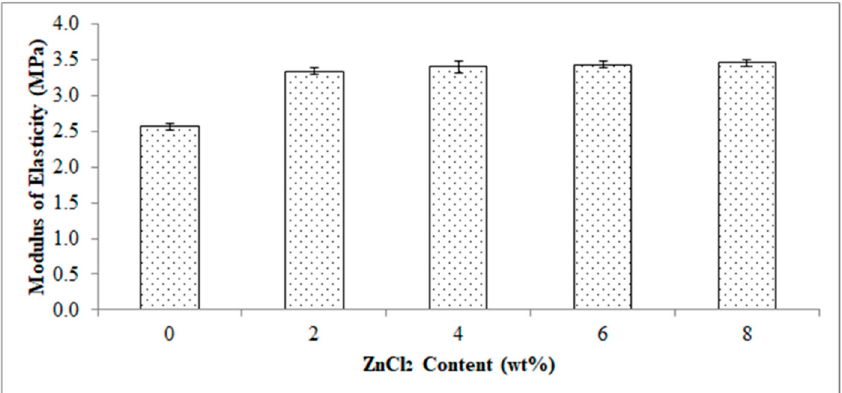
Figure 5. Effect of ZnCl 2 content on modulus of elasticity of EVA/CWF composites.